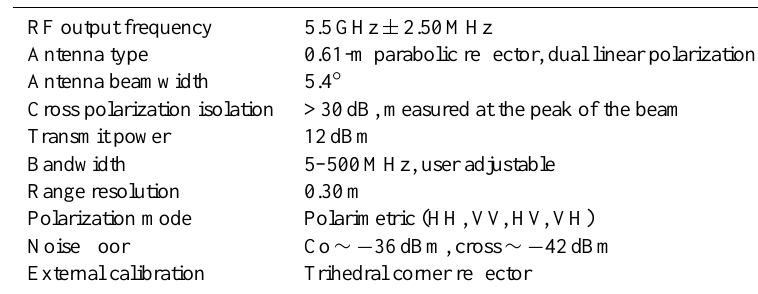
Table 1. C-band scatterometer specifications.